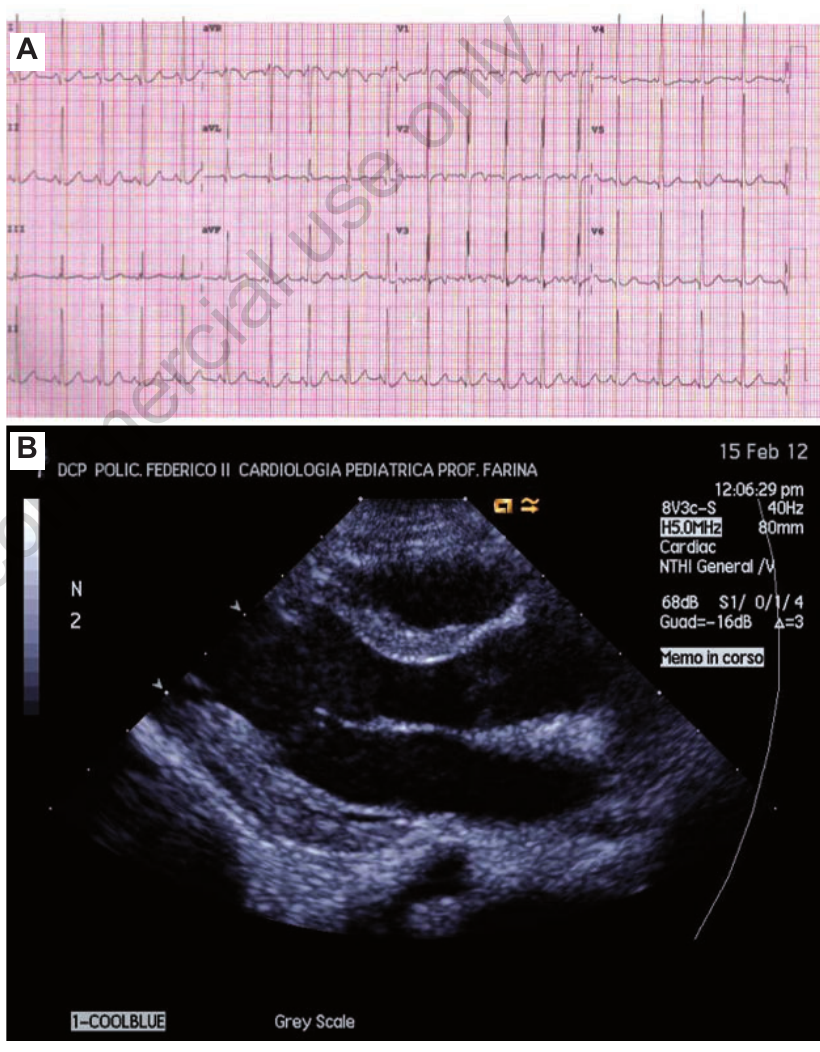
Figure 2. Patient No. 1: Severe, infantile hypertrophic cardiomyopathy with systolic dys- function, on diuretics, ACE-inhibitors, and digitalis. Enzyme replacement therapy start- ed at 3 months of life. A progressive cardiac ventricular remodeling has been observed during follow-up. A) Electrocardiogram showing short PR, mild signs of left ventricular hypertrophy without repolarization abnormalities. B) Normalization of wall thickness, ventricular diameters, and left ventricular systolic